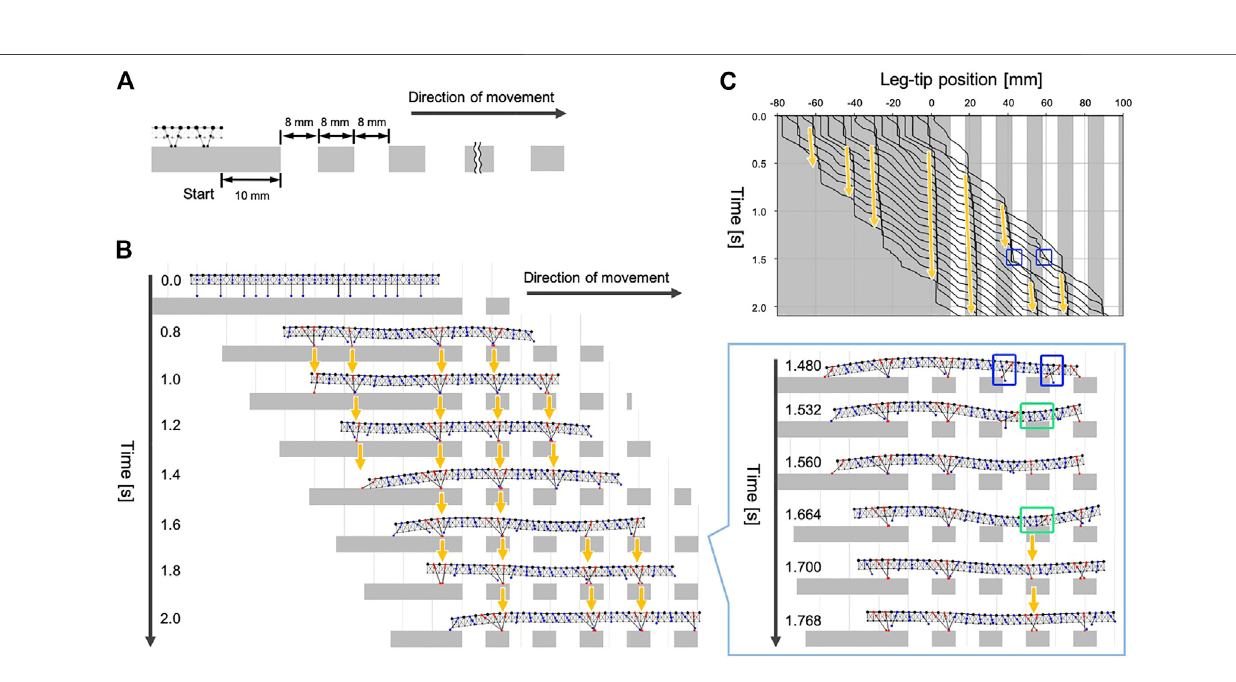
Frontiers in Robotics and AI |